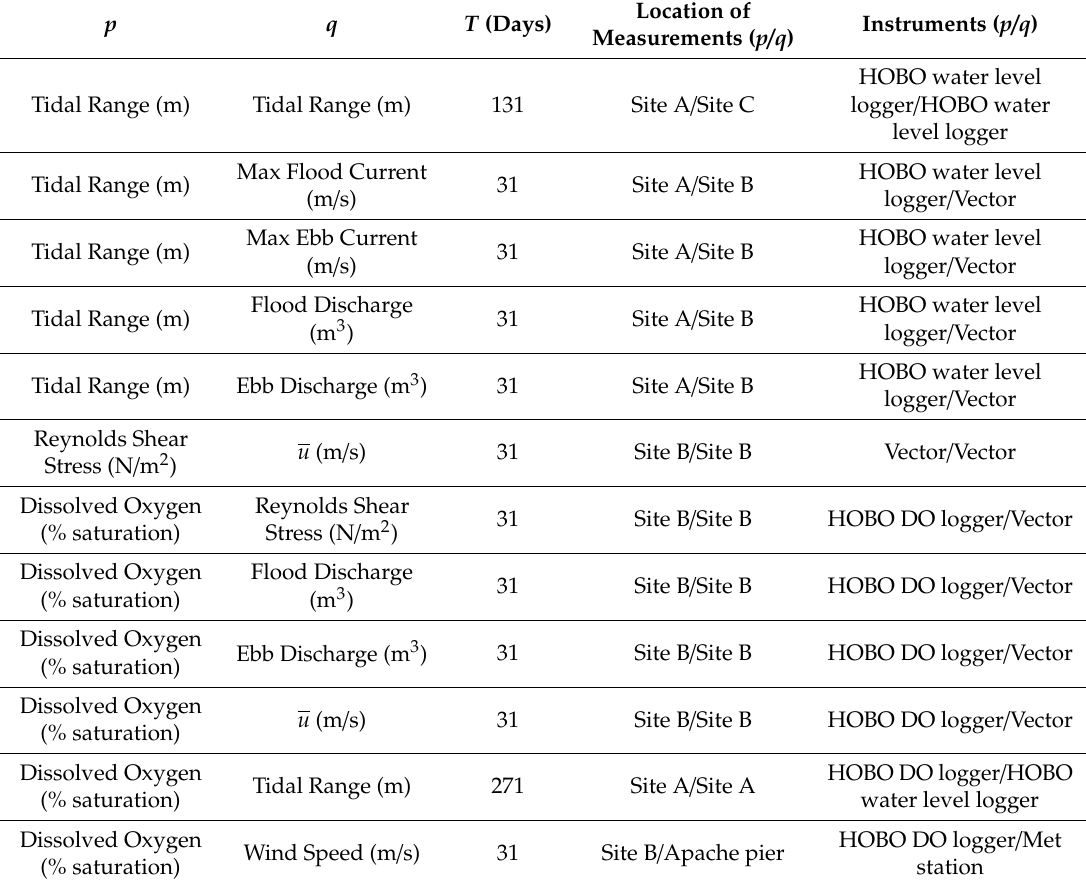
Table 1. Time series used in Equation (4) for both correlation variables ( p , q ), sampling period ( T ), location of the measurement corresponding to each variable, and the instrument used to perform the measurement.